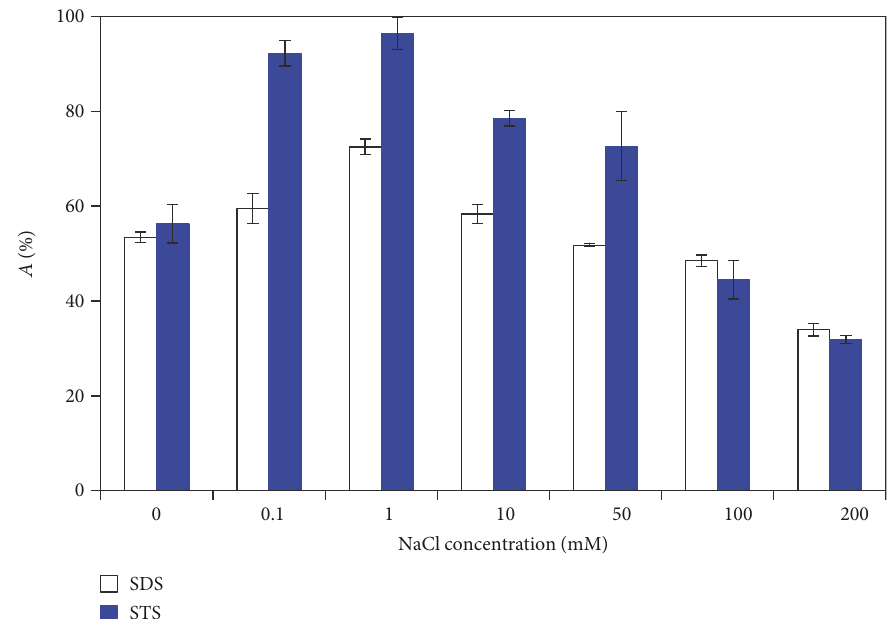
Figure 4: E ff ect of ionic strength on the adsorption e ffi ciency of SDS and STS onto Al replicates.